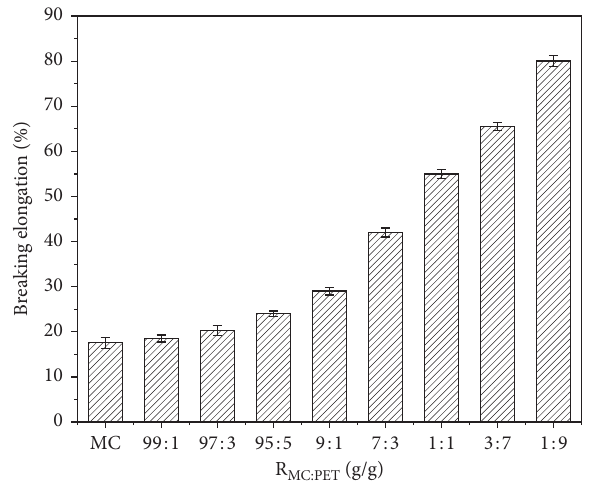
Figure 6: MC/PET mass ratio (R MC:PET ) dependent on breaking elongation of the neat MC film and MC/PET